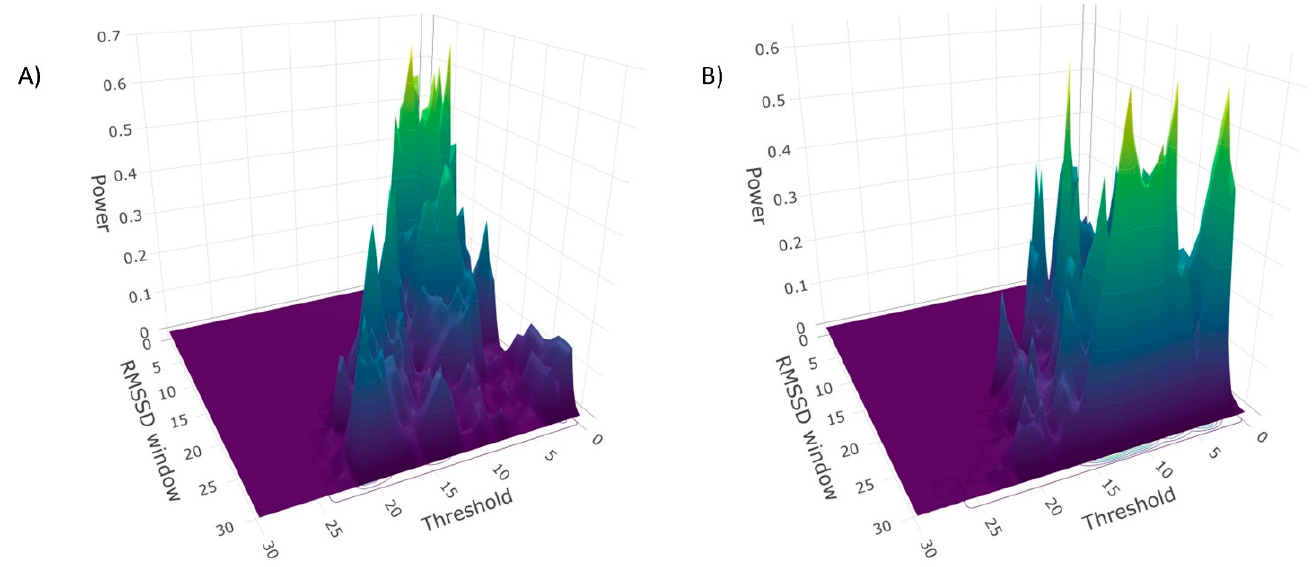
Figure 5. Left panel ( A ) illustrates the power for each of the 435 bootstrapped multi-level analyses using the dynamic algorithm settings of RMSSD window length ( x -axis) and window threshold ( y -axis; i.e., y out of x to be a trigger; see [29] for an interactive 3D illustration). Panel ( B ) illustrates the power for each of the 435 bootstrapped multi-level analyses using the static algorithm (500 samples with n = 38; for an interactive 3D illustration see [30]). The silent setting of both figures was 20 min. Since the achieved power of the dynamic algorithm did not reach the 0.70 threshold,